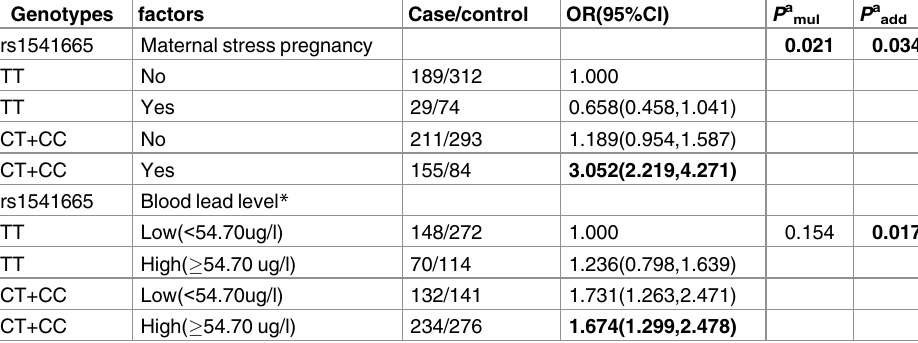
Table 6. Interaction analysis between environmental factors and polymorphisms associated with ADHD risk in combined